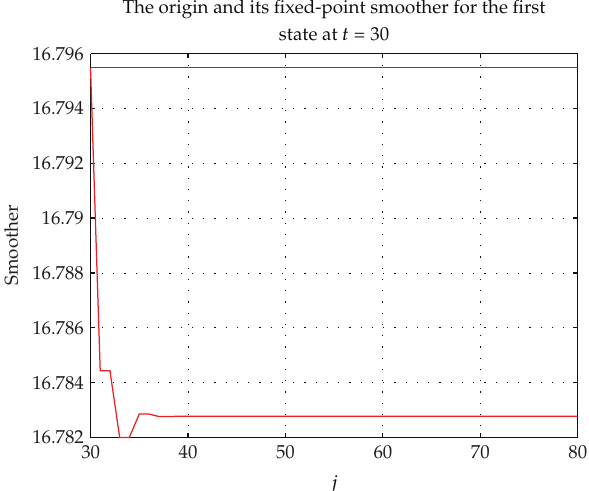
Figure 1: The origin and its fixed-point smoother (cid:13) x 1 (cid:2) 30 | j (cid:3) , where the blue line is the origin signal, the red line is the